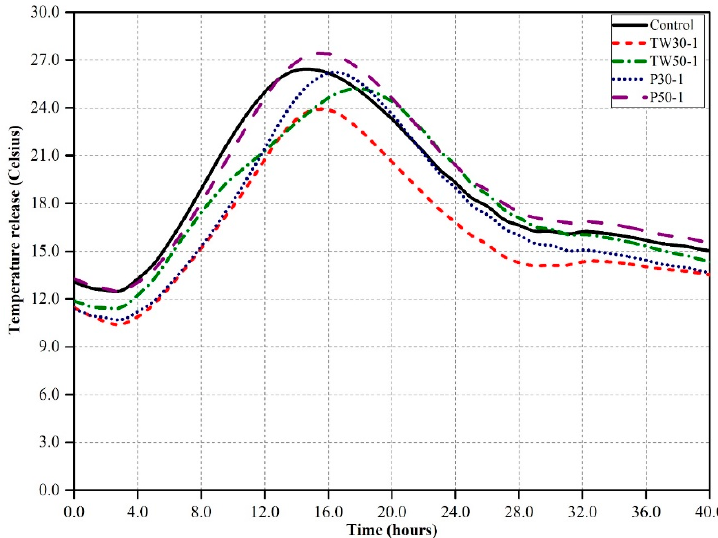
Figure 2. Temperature release of the control mix and mixes containing 1% internal curing agents (ICA) over 40 h.